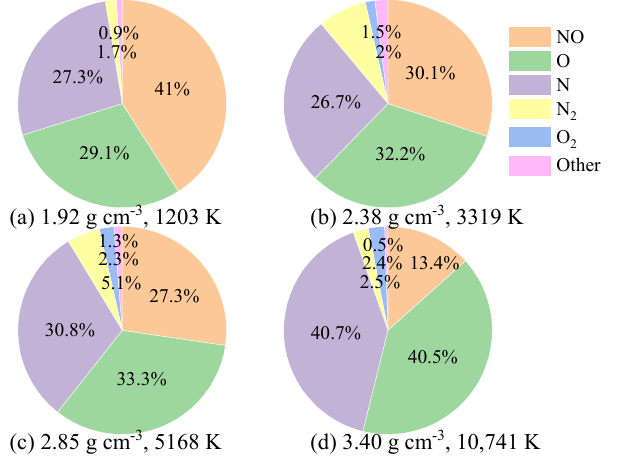
Figure 5. Fractions of components in warm dense NO along Hugoniot using PBE functional. The components contain NO molecules, N and O atoms, N 2 and O 2 molecules, and Other.